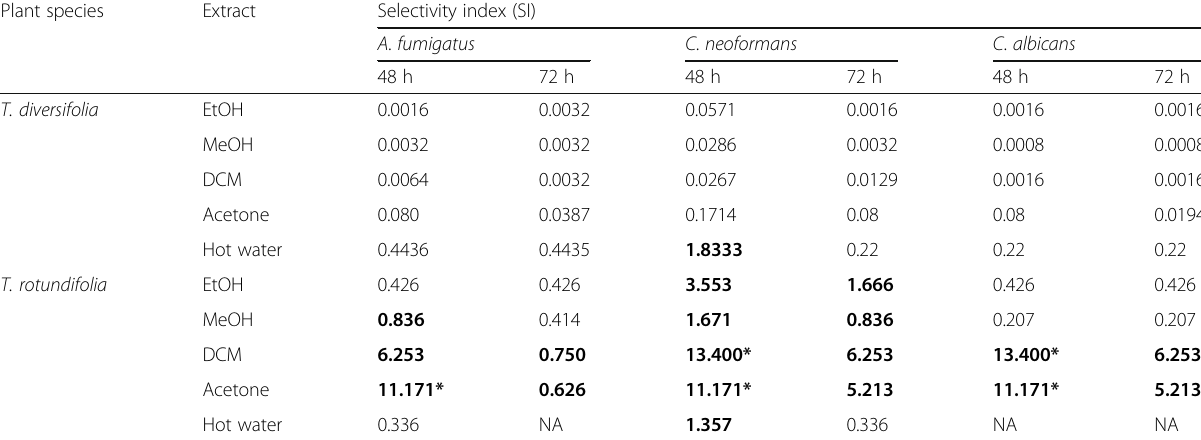
Table 7 Selectivity index of fungal strains tested against T . diversifolia and T . rotundifolia solvent extracts Plant species Extract Selectivity index